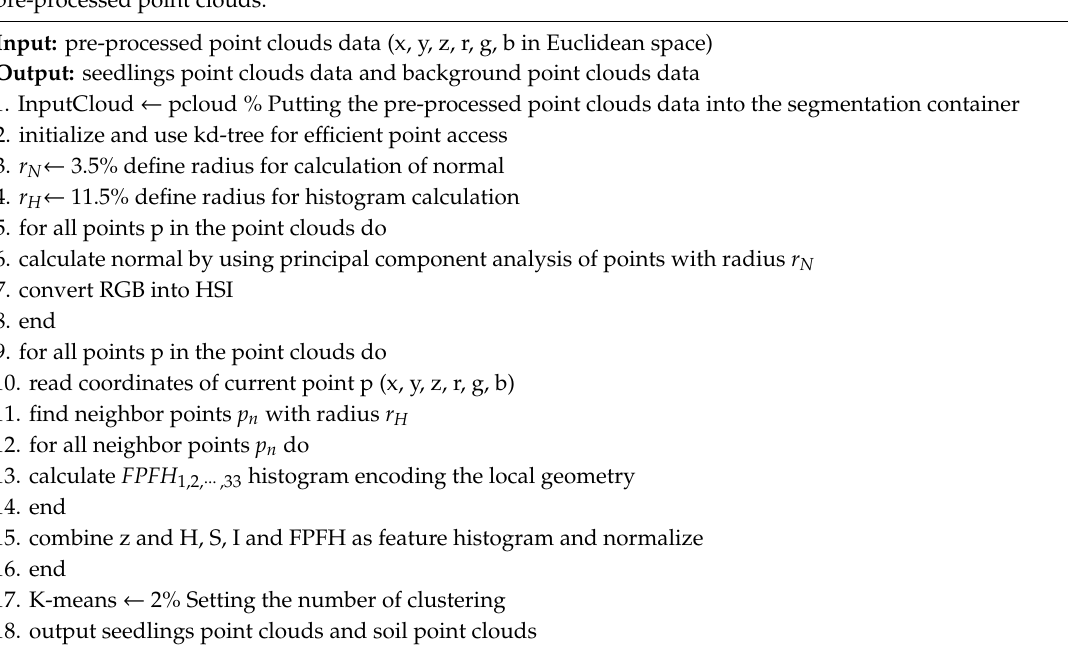
Algorithm 2. Removing background with adapted surface feature histogram-based technique of pre-processed point clouds.